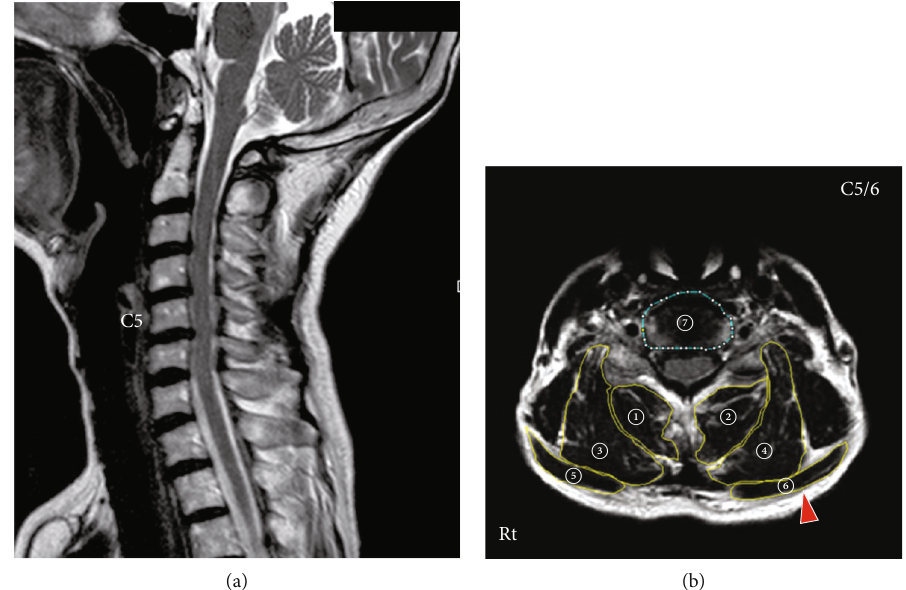
Figure 9: T2-weighted MR sagittal image (a) and axial image at C5-C6 (b) of the patient ’ s cervical spine eight months after the fi rst AR-PT. (a) Alignment of her cervical spine became normal. (b) Atrophy of her cervical extensor muscles was improved. Muscle tonus of the trapezius was restored (arrowhead). ➀➁ : deep layers of cervical extensor muscles (semispinalis cervicis and multi fi dus). ➂➃ : lateral-dorsal layers of cervical extensor muscles (splenius capitis, splenius cervicis, and longissimus). ➄➅ : trapezius. ➆ : C5-C6 disc.